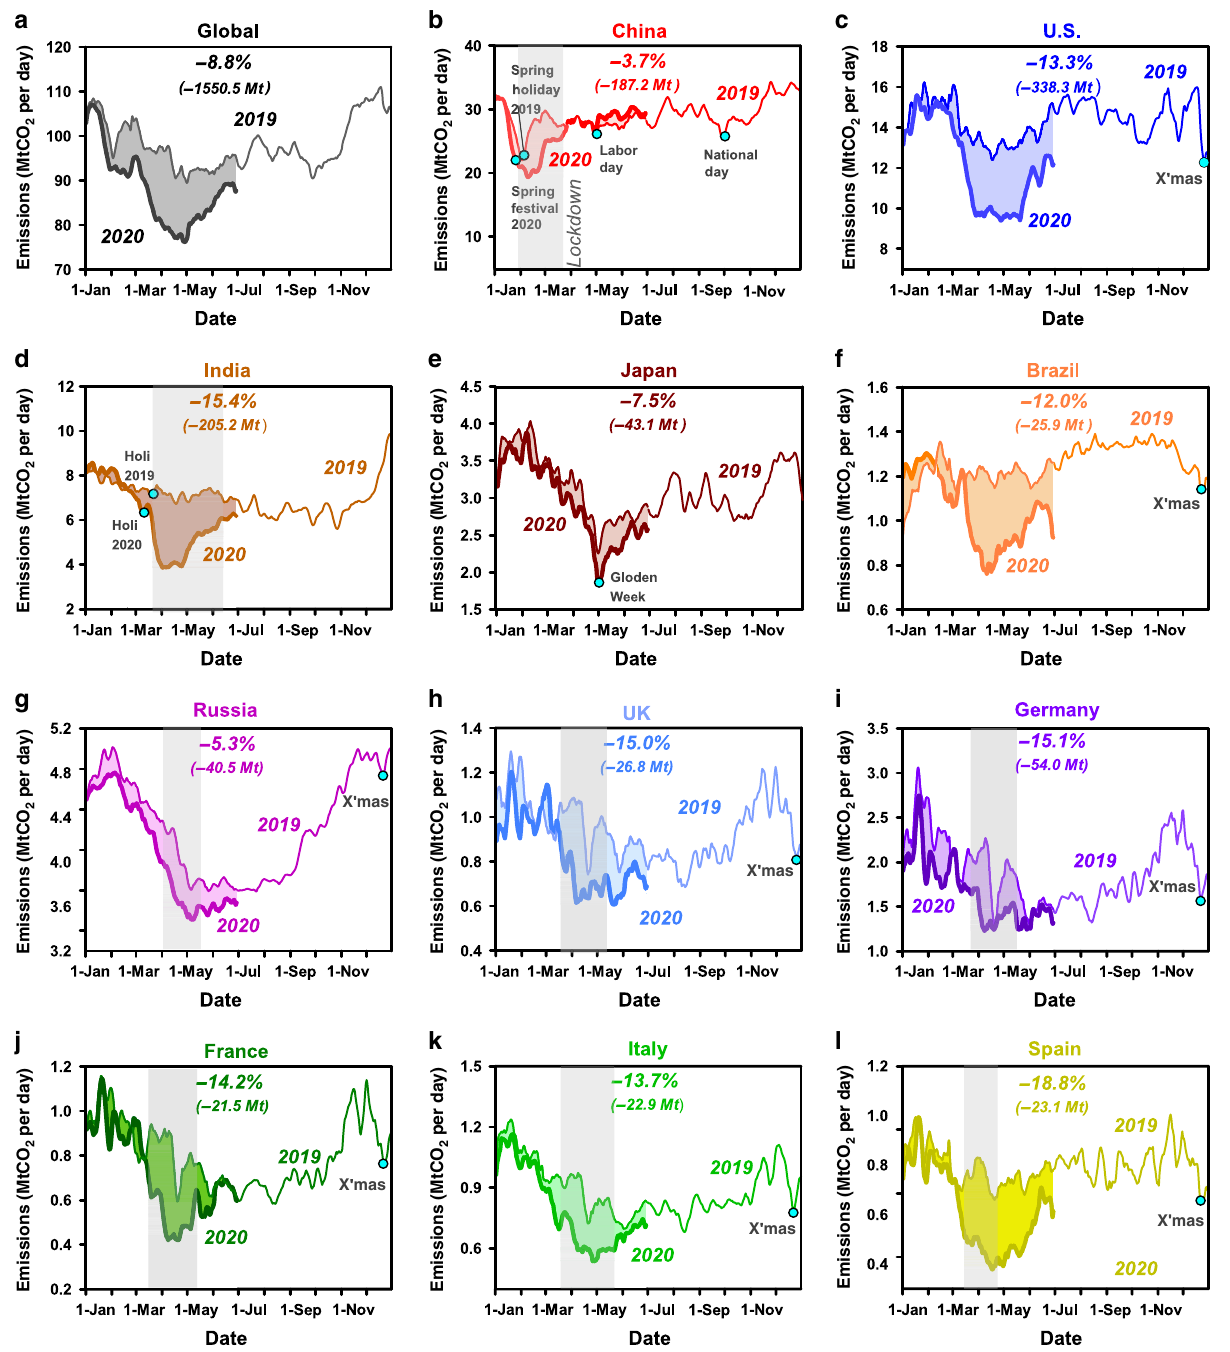
Fig. 2 Daily CO 2 emissions for countries. Effects of the COVID-19 pandemic on daily CO 2 emissions globally and in each of 11 regions are re fl ected by the shaded differences between January 1st and June 30th of 2019 and